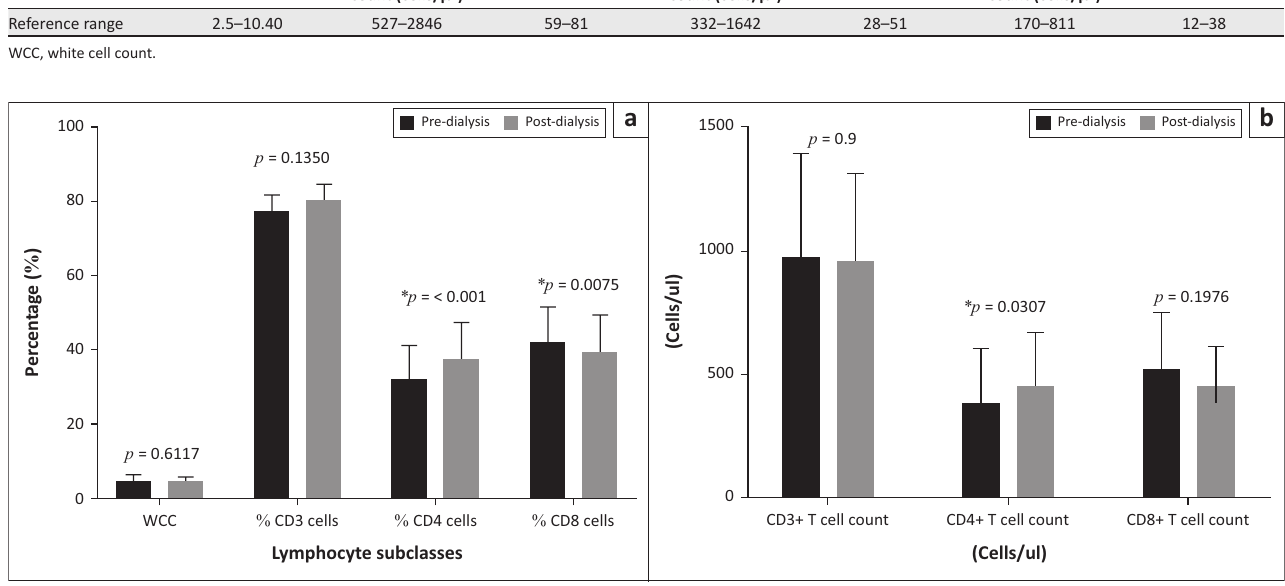
FIGURE 1: Measured parameters of study participants pre- and 7.106, p = 0.001) as well as the absolute CD4+ T-cell count counts ( t = 2.371, p = 0.032). A statistically significant decrease in the post-dialysis percentage of the CD8+ T cells ( t = 3.212, p = 0.008) was found (Figure 1). Figure 1: Measured parameters of study participants pre- and post-dialysis For the study controls, the percentage of CD4+ T cells was the only immunological parameter to show a statistically significant increase after haemodialysis ( t = 4.195, p = 0.001).